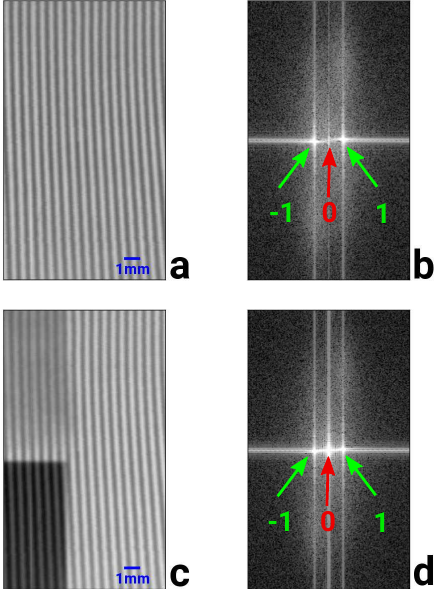
Figure 3. ( a ) reference Talbot-moiré image; ( b ) two-dimensional FT of ( a ); ( c ) selected area of the Talbot-moiré image of the phantom shown in Figure 2. The moiré pattern (stripes) is distorted by the sponge ( top ) and the PMMA step-wedge ( bottom ); ( d ) two-dimensional FT of ( c ). The green arrows mark the − 1st and 1st harmonics that are located at the frequency of the moiré pattern. The red arrow marks the 0th harmonic that is located at the zero frequency position. The images correspond to the green area in Figure 2.